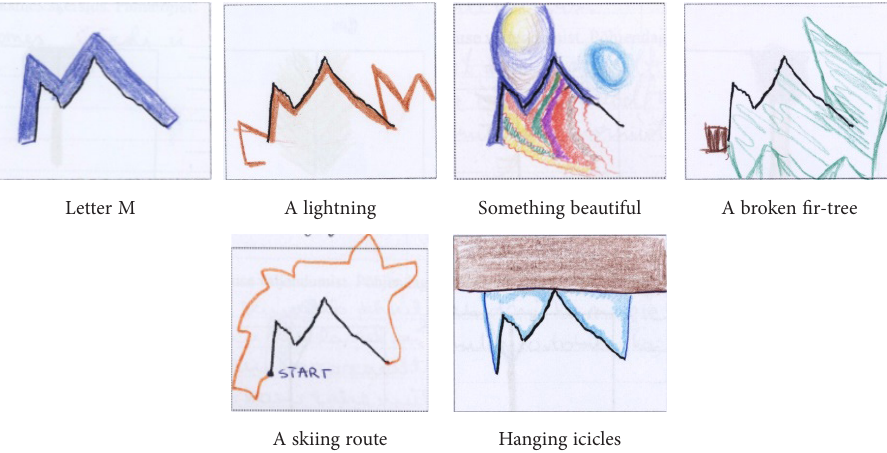
Figure 28. The creative task: interpretation of Fragment 4 – exceptional images (source: testingmom.com,